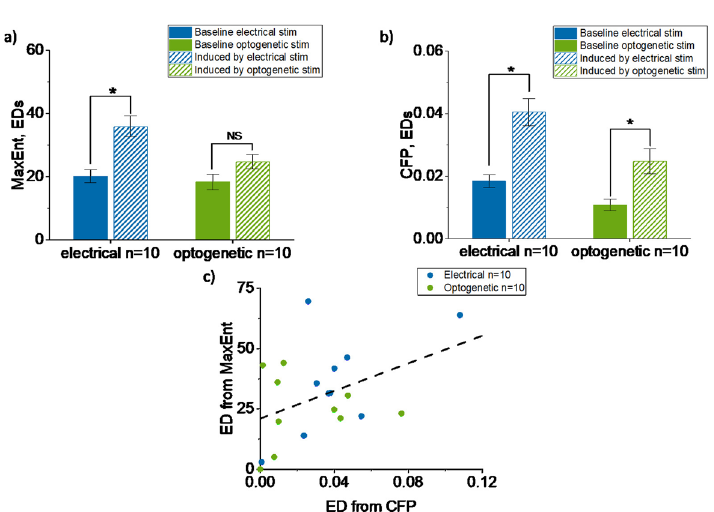
Figure 5. Connectivity changes induced by electrical (blue) and optogenetic stimulation (green). Euclidean distances were calculated first within baseline recordings, and then between the connectivity matrices before and after a 20 h stimulation period. ( a ) Comparison between connectivity changes within baseline with the ones induced by the different stimulation modalities, obtained from MaxEnt (electrical p = 0.004 , optogenetic p = 0.16 ). ( b ) Same as panel A but results obtained using CFP (electrical p = 0.02 , optogenetic p = 0.01 ). Error bars indicate SEM. ( c ) ED calculated based on all connections in CFP connectivity matrices ( ED CFP ) and MaxEnt matrices ( ED MaxEnt ). Correlation coefficient: R = 0.42 . Black dashed line shows fitted linear